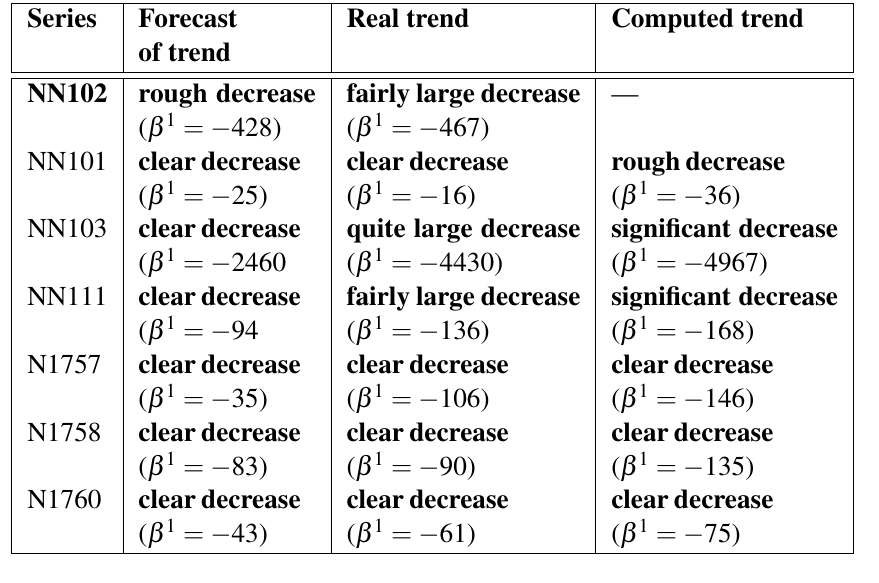
Table 1: Group G 1 :